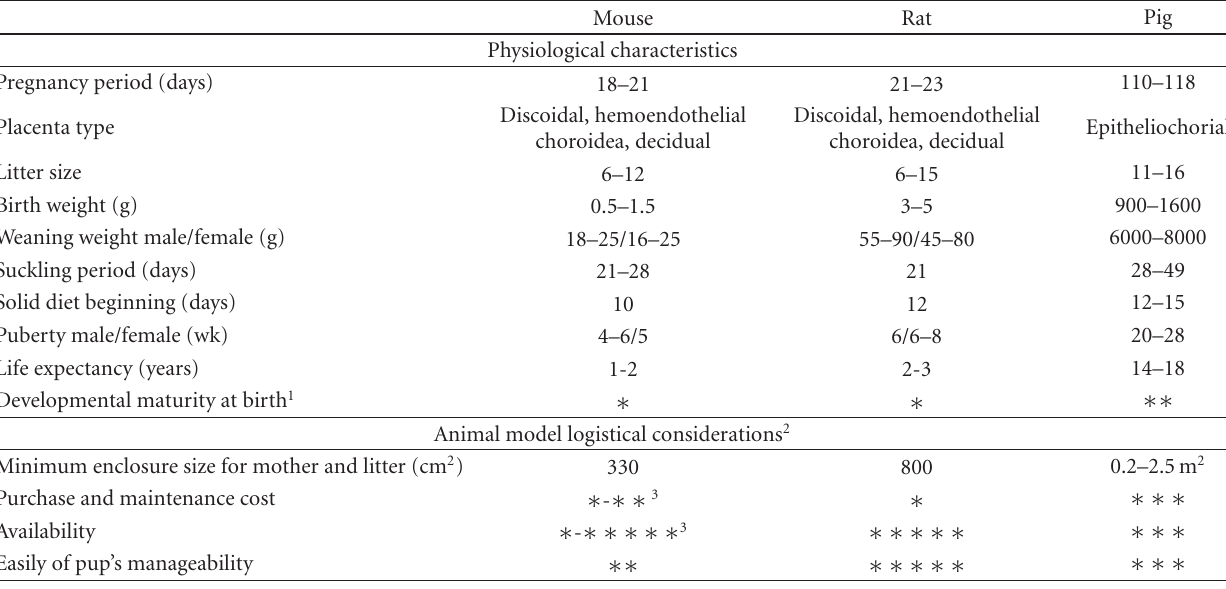
Table 1: Physiological characteristics and logistical considerations of the three most used animal models for nutritional intervention in early life